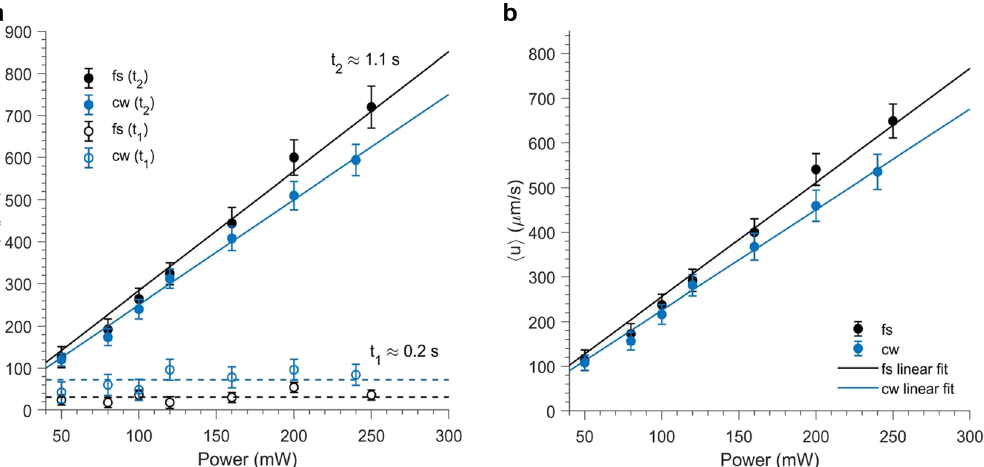
Figure 10: Comparison of (a) the displacement δ y , and (b) the average velocity 〈 u 〉 of the beam pro fi le due to convection under fs and cw operationonsample S 1and d = 15 mmas afunctionof inputpower.The δ y valuesareshownfortwodifferenttimes t 1 and t 2 aftertheopening of the shutter. The solid lines are linear fi ttings and the dashed lines in (a) show the average value of data taken for t 1 at each case. The 〈 u 〉 values are calculated for time t 2 after the opening of the